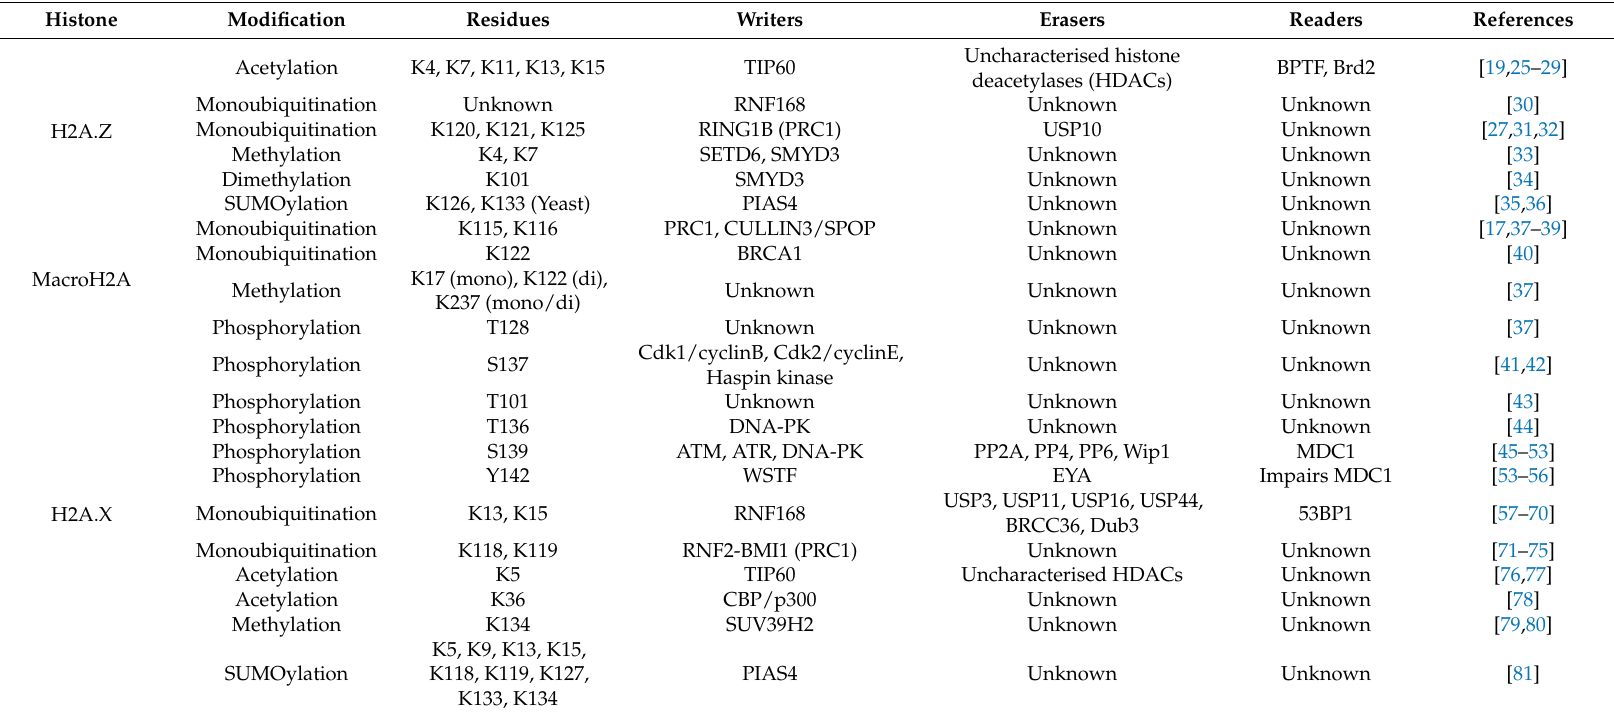
Table 1. H2A variants and their Post-translational modifications